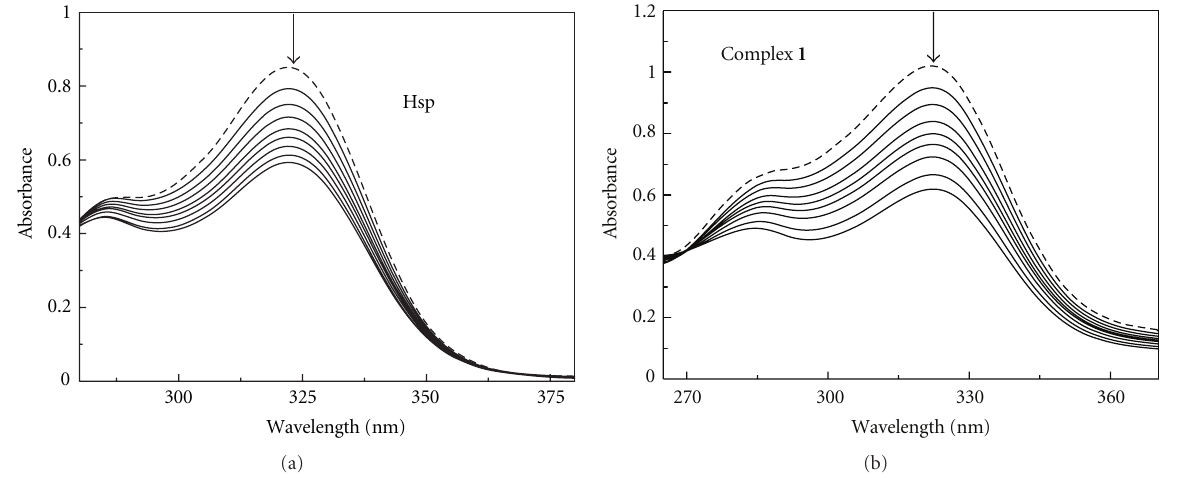
Figure 3: UV-Vis spectra of Hsp and complex 1 in the absence (----) and presence (—) of increasing amounts DNA.